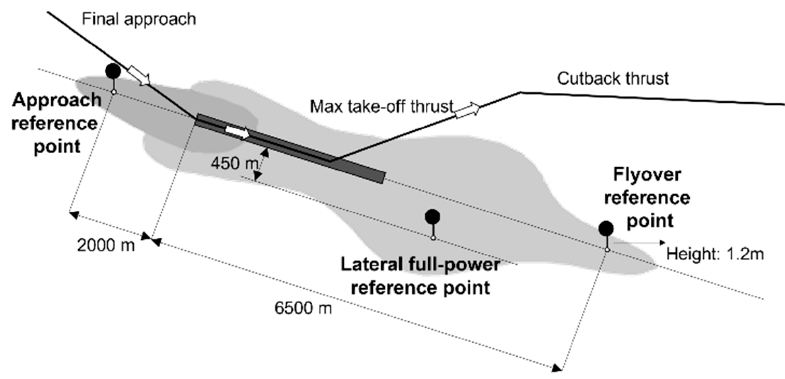
Figure 7. Reference measurement points in noise certification tests. Table 2. Noise levels for B737-800 and A320-211 aircraft at three certification points, as measured and calculated (in EPNdB) with associated errors (in percentage).